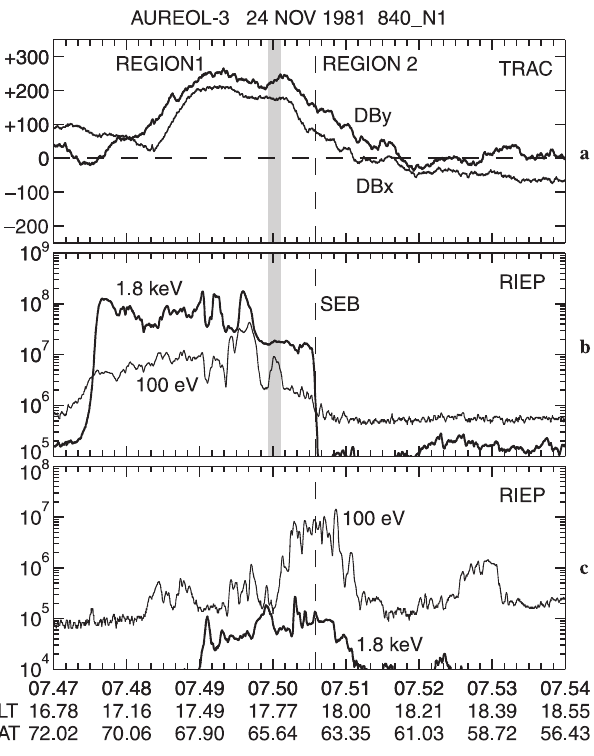
Fig. 5a–c. Pass 840 N1, from top to bottom: a DB variations of the horizontal magnetic field (TRAC magnetometer); b electron di(cid:128)erential fluxes at 2 fixed energies, 100 eV and 1.8 keV (RIEP spectrometer); c proton di(cid:128)erential fluxes at 100 and 1.8 keV. The sampling rate for the TRAC and RIEP instruments is 320 ms, and running averages on 1.6 s are plotted in the three panels. The auroral arc is indicated by a vertical grey band, and the SEB boundary is referenced by a vertical dashed line (see text